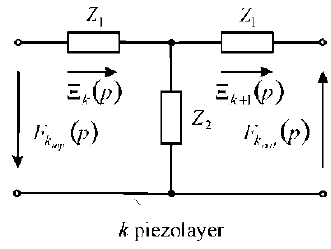
Figure 2. Quadripole for the k piezolayer.